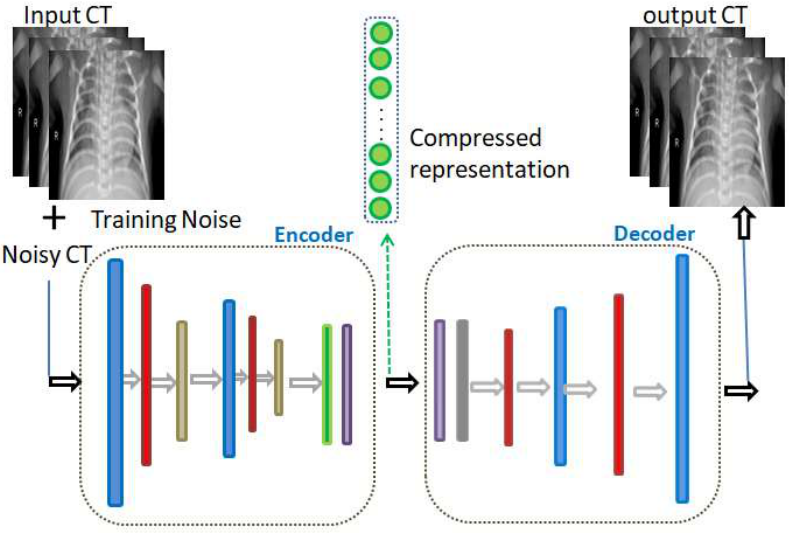
Figure 2. illustration of the deep denoising autoencoder. Figure 2. Illustration of the deep denoising autoencoder.